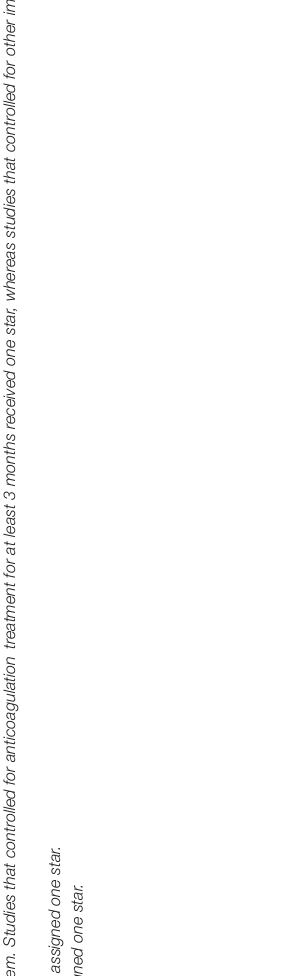
( Figure 9 ) and nDOACs group. Subgroup analysis based on study type did not reach statistical significance (RCTs: Supplementary Figure 5 ; prospective cohort studies: Supplementary Figure 6